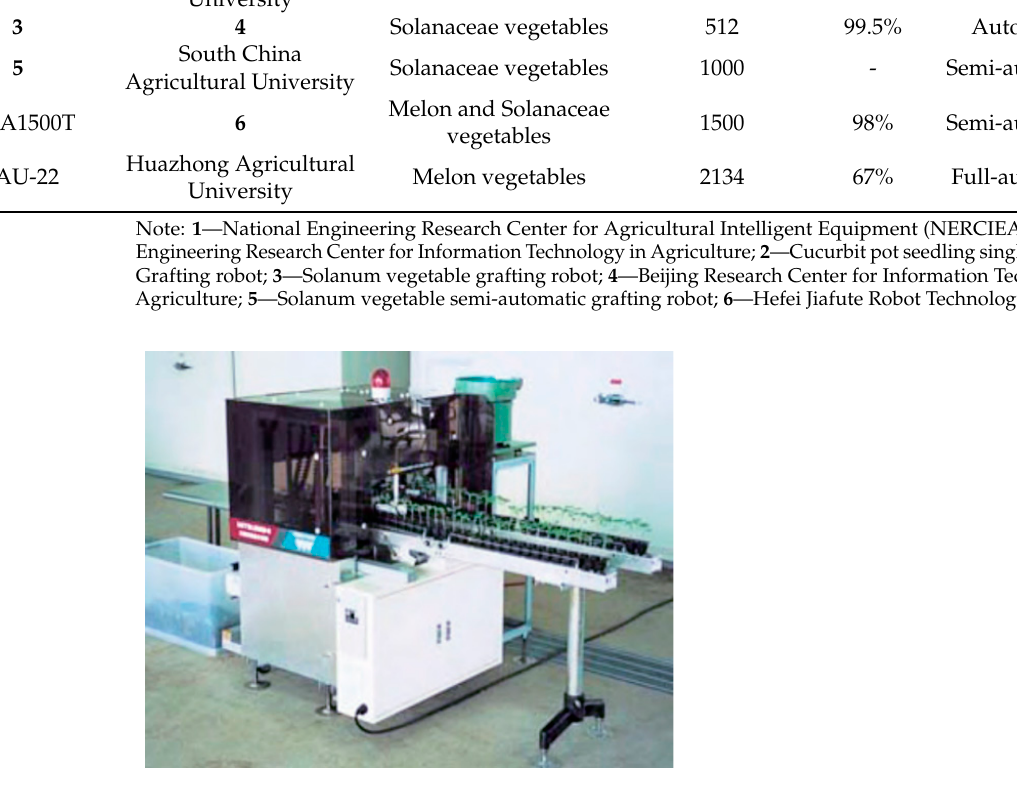
Figure 4. MGM600 semi-automatic grafting robot developed by Mitsubishi Group.